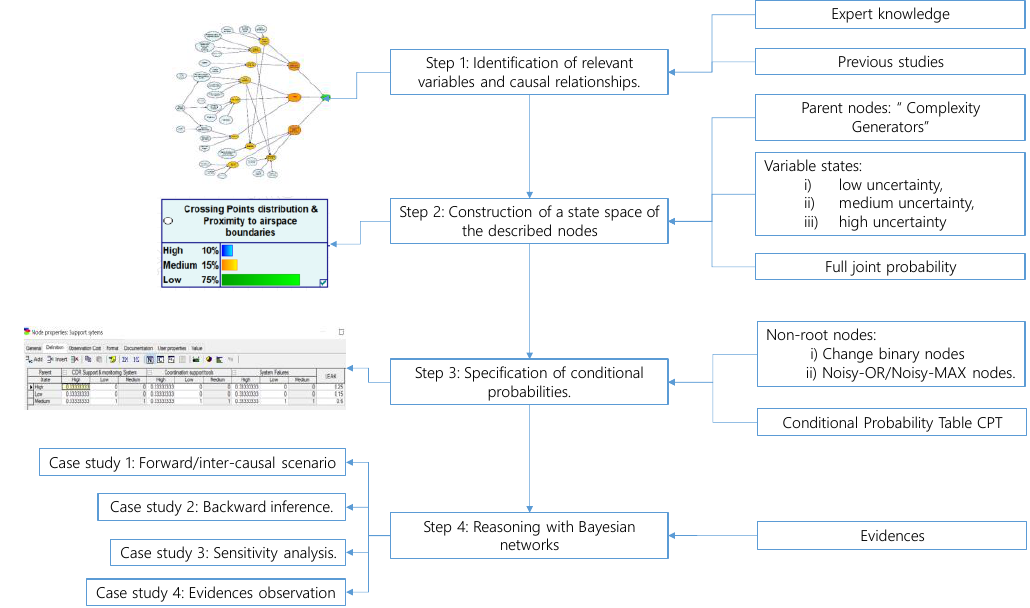
Figure 5. Steps in the construction of a generic Bayesian Network for complexity.